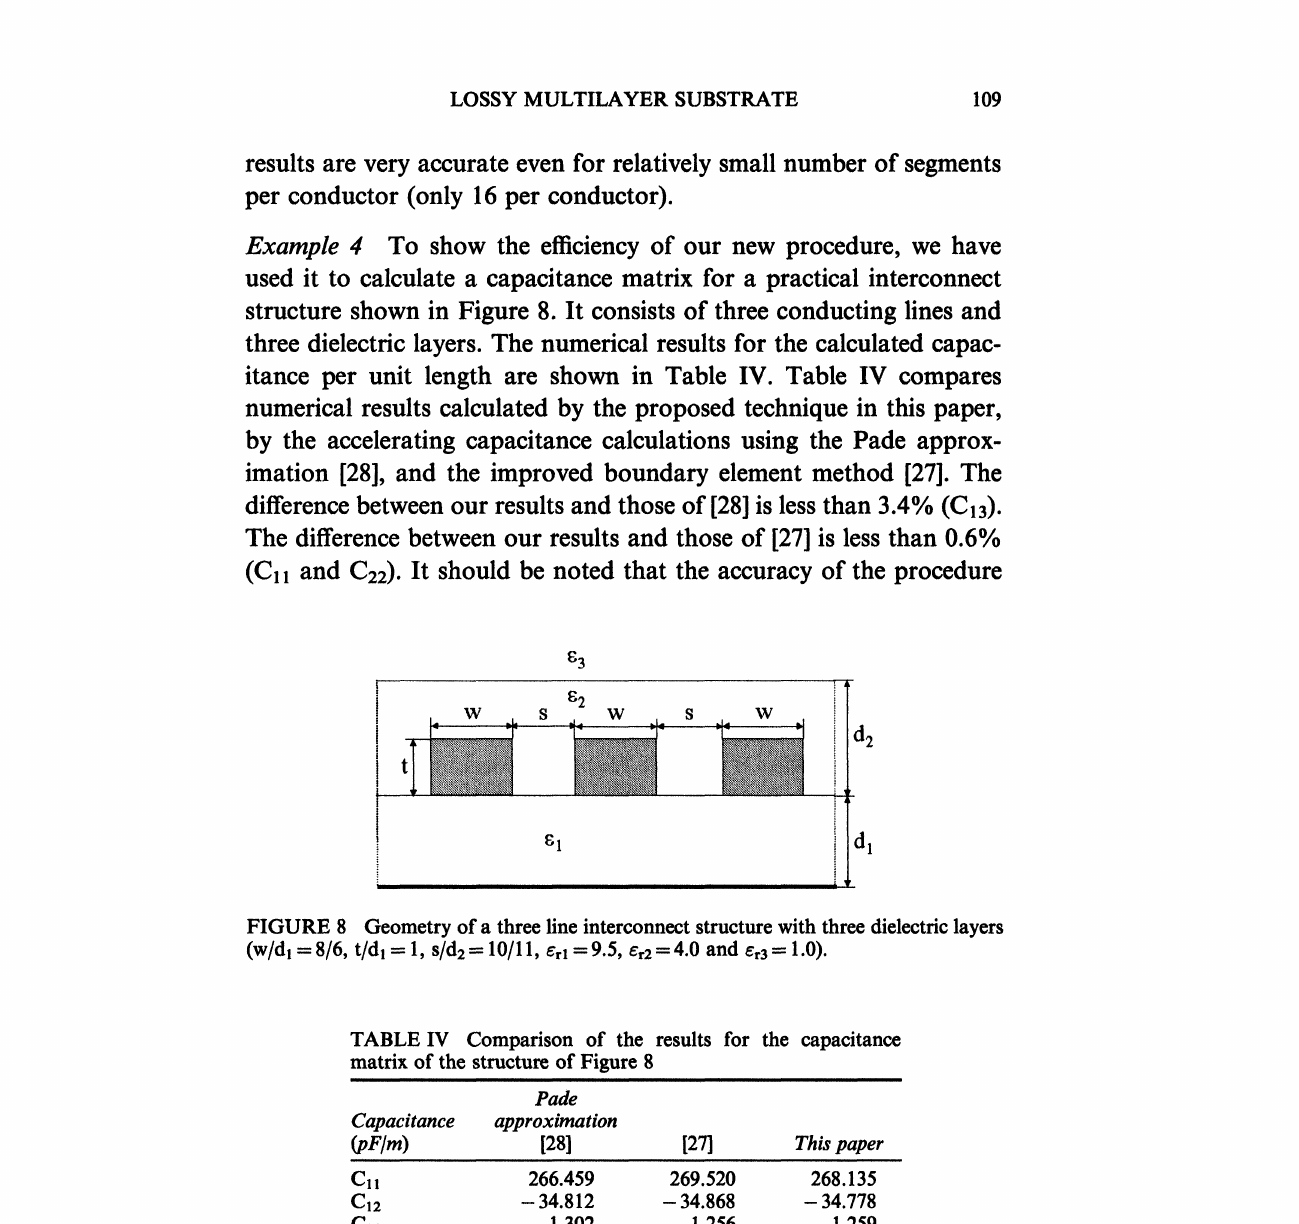
FIGURE 8 Geometry of a three line interconnect structure with three dielectric layers (w/d1 =8/6, t/d1 1, s/d2= 10/11, er =9.5, ca=4.0 and st3 1.0).